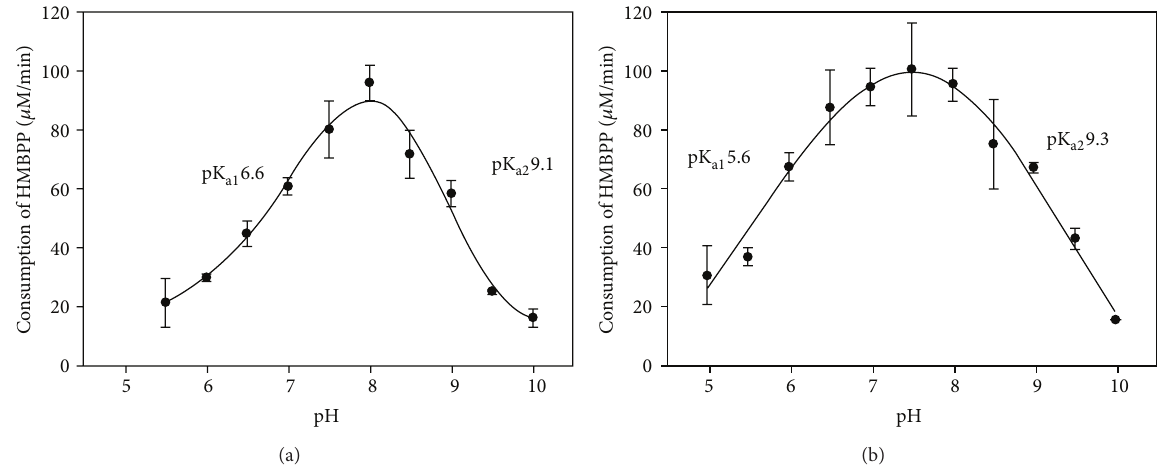
Figure 3: The pH-dependent activity profiles of GbIspH1-full (a) and GbIspH1-truncated (b).